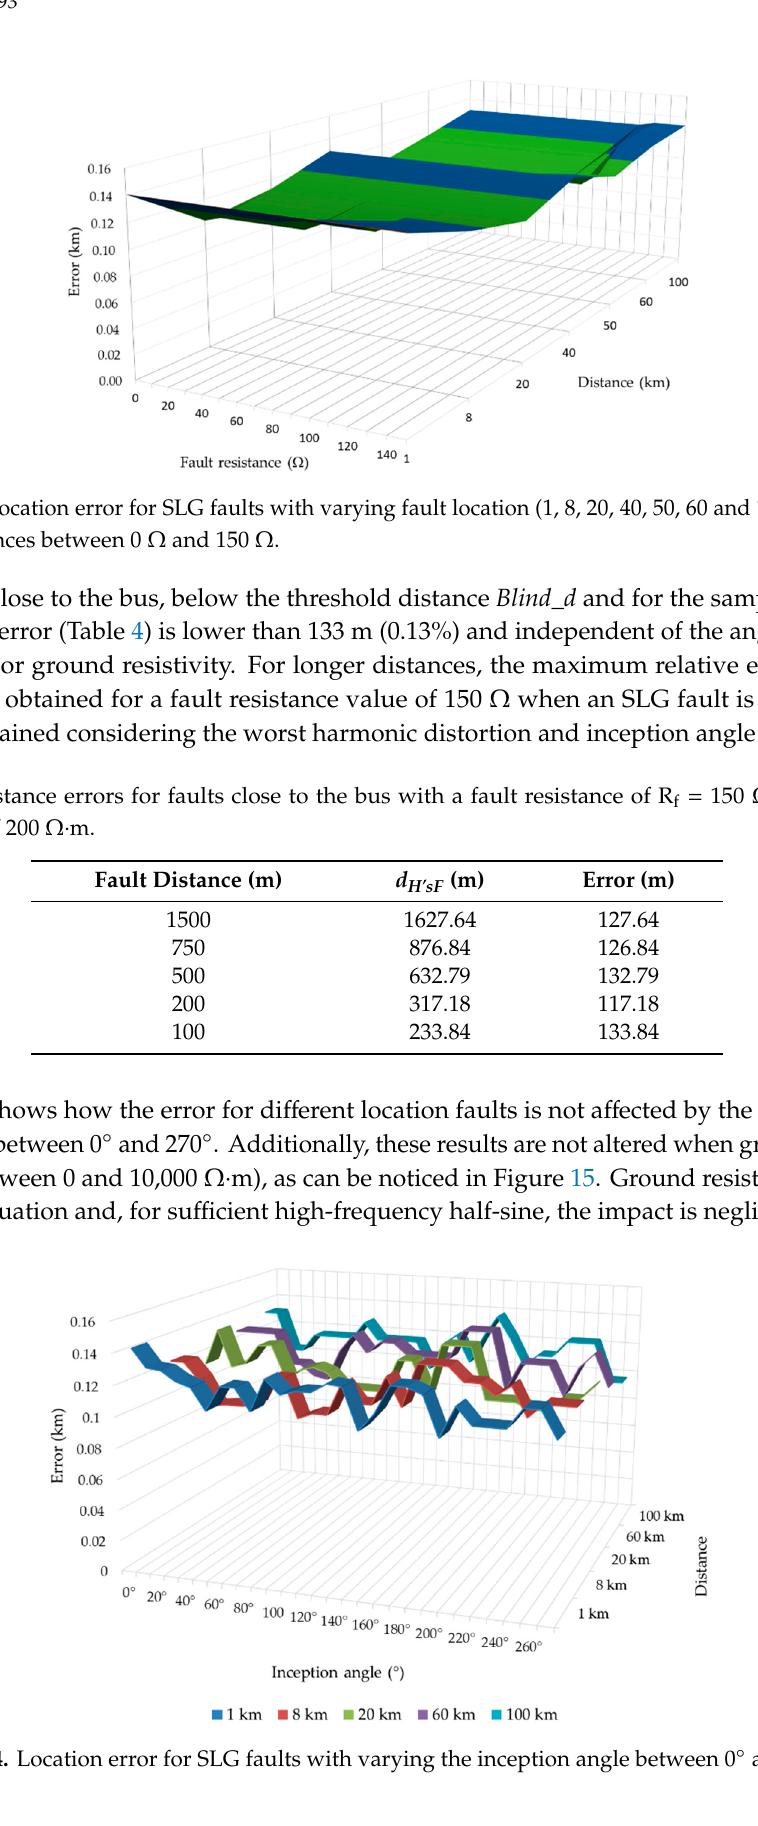
Figure 15. Location error for SLG faults with varying the soil resistivity. In Table 5 the proposed method is compared with several methods: a traditional distance algorithm (DFFT distance algorithm) [27], a distance relaying scheme based on the current phase